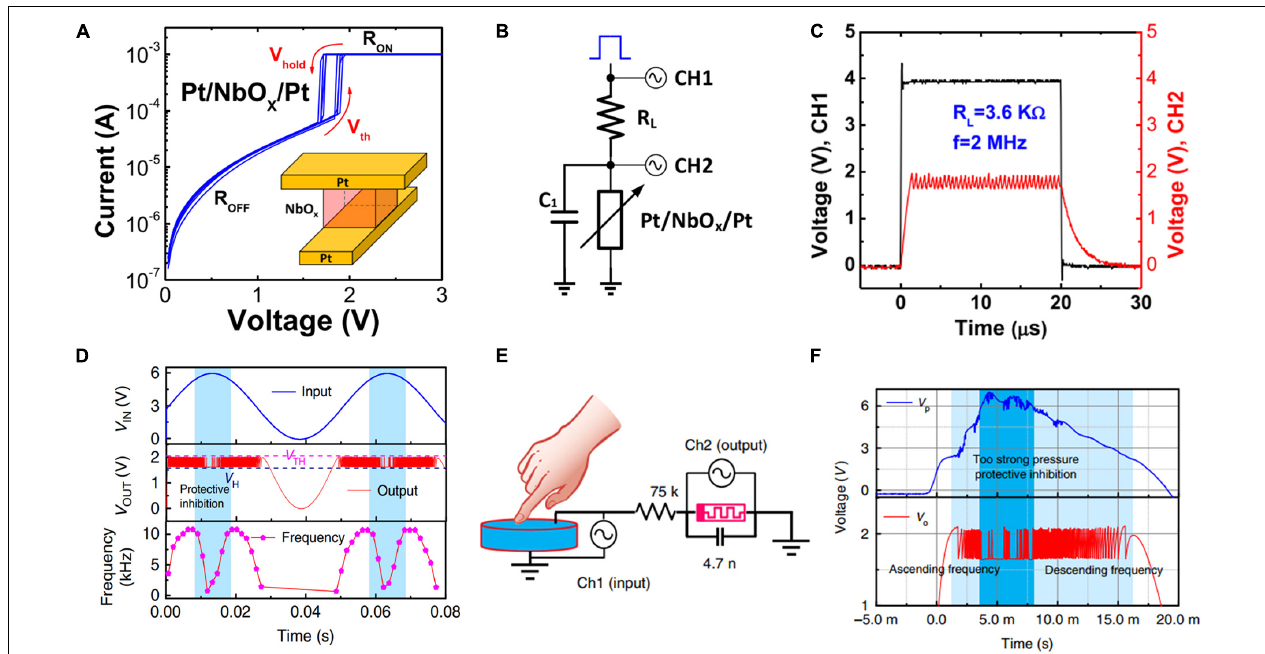
FIGURE 10 | (A) Measured I–V threshold switching characteristics of the Pt/NbO x /Pt device. Inset depicts the schematic of the fabricated Pt/NbO x /Pt device. (B) Circuit configuration of an oscillating neuron node with the Pt/NbO x /Pt device and a load tunable resistor as a synapse. (C) Oscillation characteristics when the load resistor is 3.6 k (cid:127) and output frequency is 2 MHz (Gao et al., 2017). (D) Dependence of the output frequency on the input voltage amplitude. (E) Schematic of the artificial spiking mechanoreceptor system. (F) Dependence of the output spike frequency on the pressure. When the pressure is extremely high, frequency adaptation action protects the device (Zhang et al.,